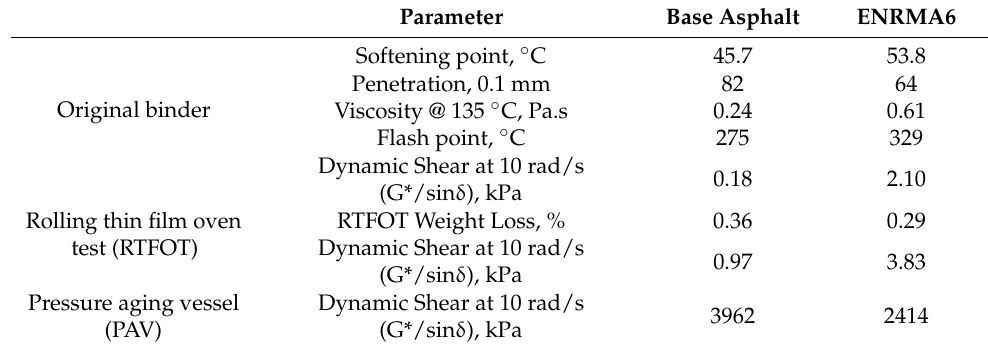
Table 3. Binder properties.